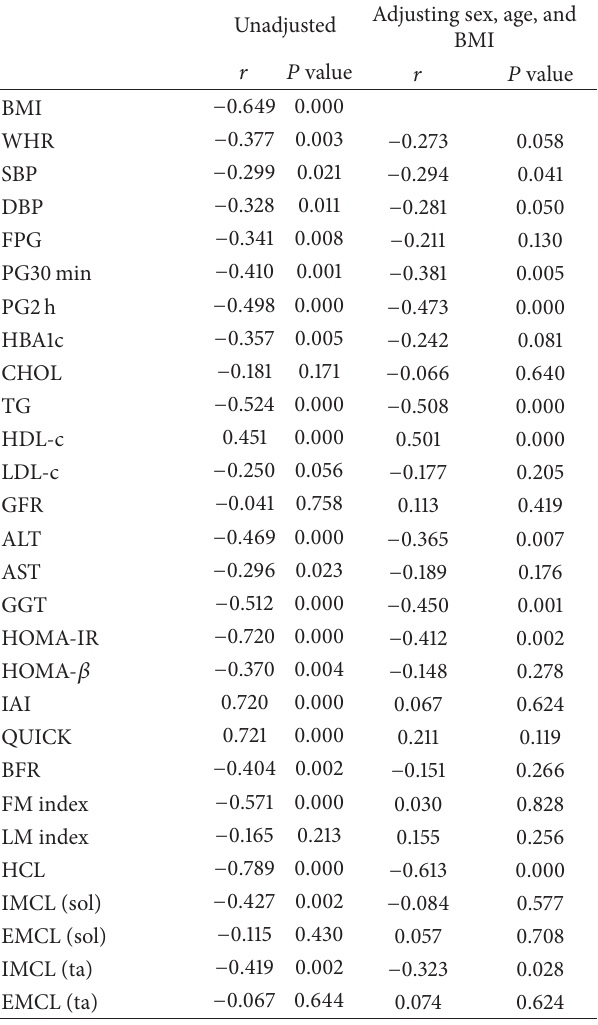
Table 4: Association of 𝑀 value with variables.